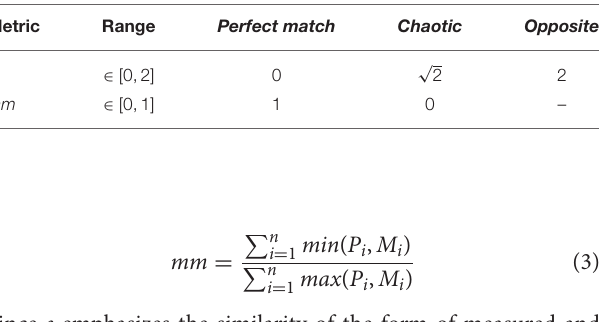
TABLE 1 | Basic properties of the metrics s and mm